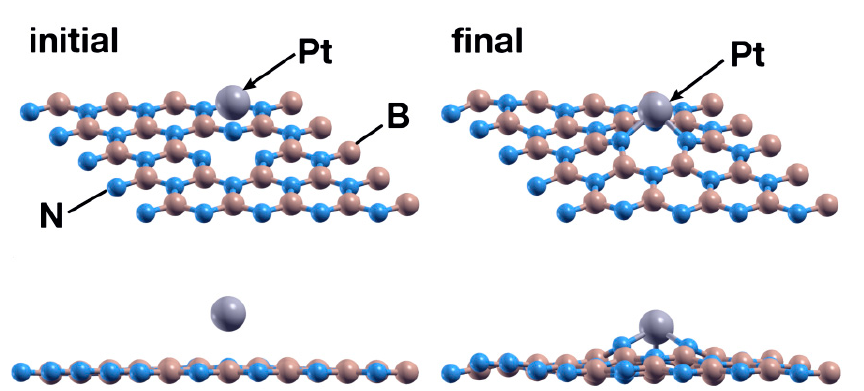
Figure 8. Initial ( left ) and final ( right ) configurations for the interaction of the hBN surface with a B vacancy and a Pt atom. The Pt atom chemisorbs and deforms the surface slightly but more than the Ti atom does.